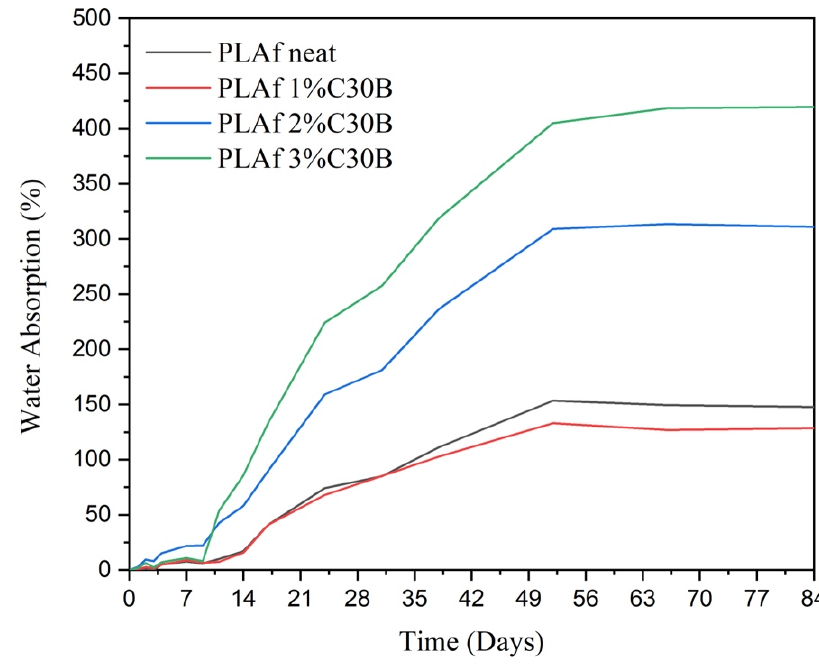
Figure 13. Water uptake of the PLA neat and PLA/C30B bionanocomposite